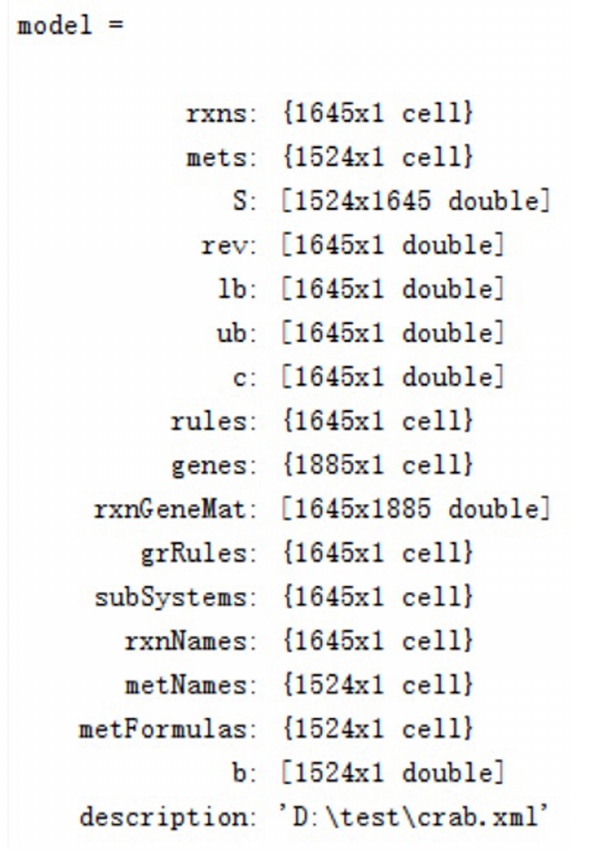
FIGURE 4 | The components of model structure in